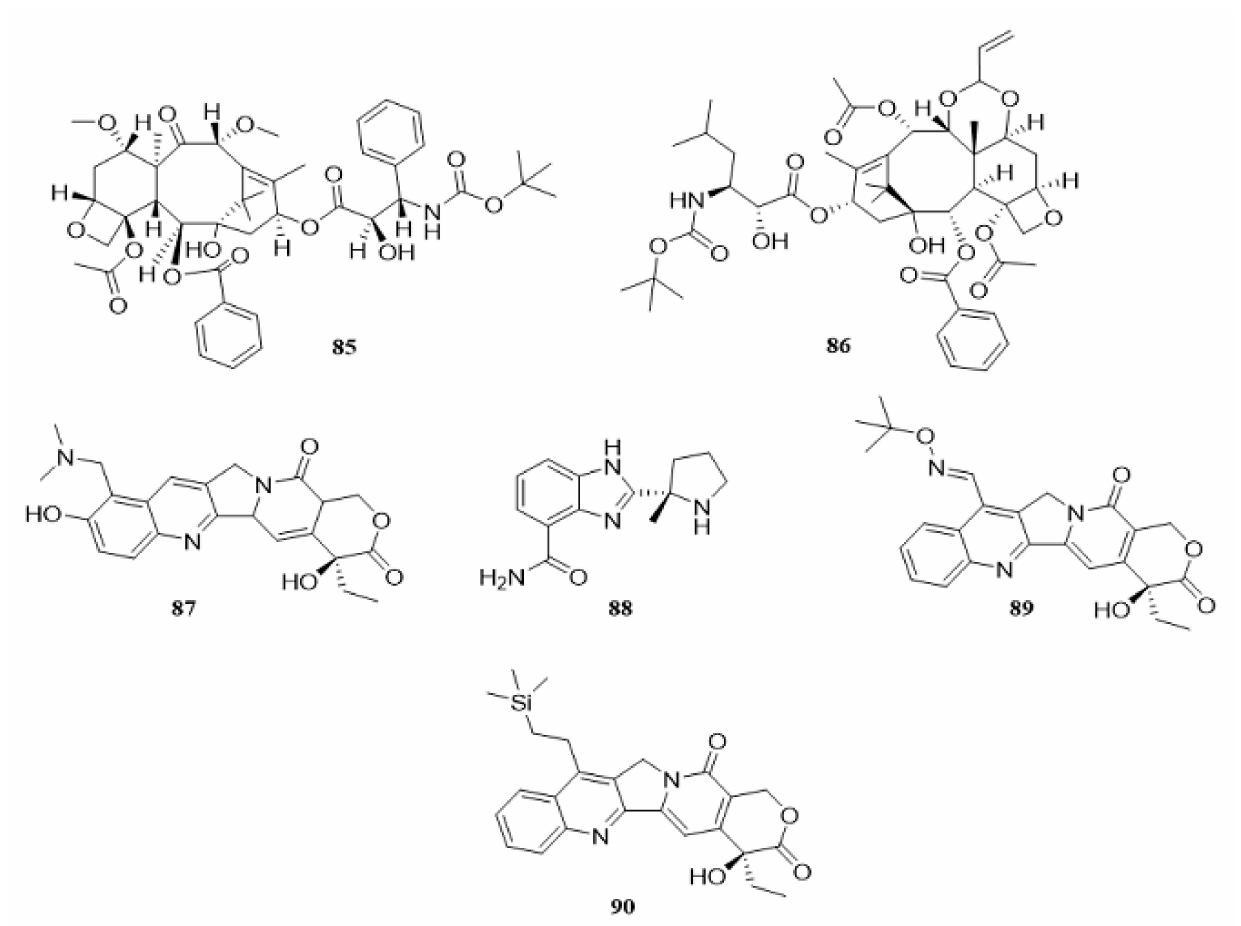
Figure 21. Chemical structures of natural compounds that have been used in clinical trials. Cabazi- taxel (85), TPI 287 (86), topotecan (87), veliparib (88), gimatecan (89), karenitecin (90). The images were prepared using ChemDraw Professional